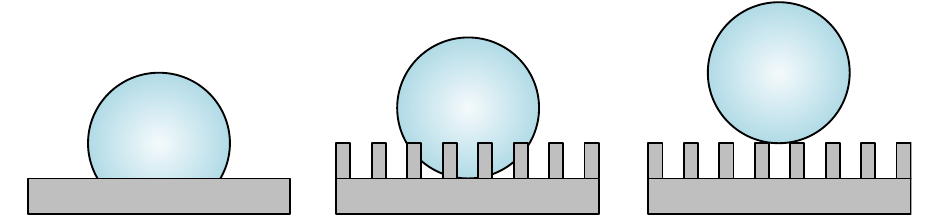
Figure 8. The state of droplets on the plane of the Young model, Wenzel model and Cassie-Baxter model.